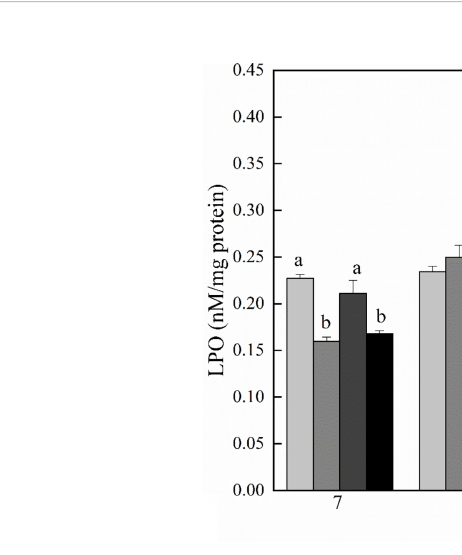
FIGURE 5 Lipid peroxidation (LPO) activities in whole tissues of Tachypleus tridentatus exposed to 100-nm micro-PS (10 4 particles l -1 ), Cu 2+ (10 µg l -1 ), and a combination of PS and Cu 2+ at days 7, 14, and 21, allowed to recover for 7 days (28 days). Data are given as mean values ± standard deviations. The superscripts of different lowercase letters indicate signi fi cant differences (p < 0.05) between the four